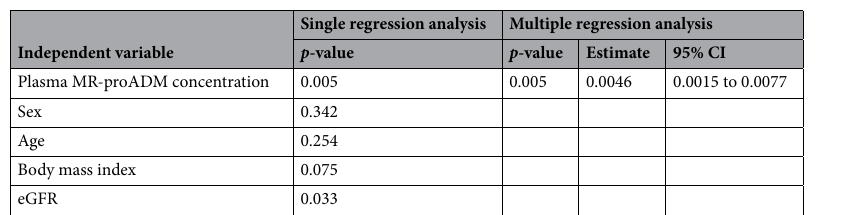
Table 3. Single and multiple regression analysis for factor associated with weight-corrected treatment intensity score. Total R 2 for the model was 0.224. MR-proADM mid-regional pro-adrenomedullin, eGFR estimated glomerular filtration rate, 95% CI 95% confidence